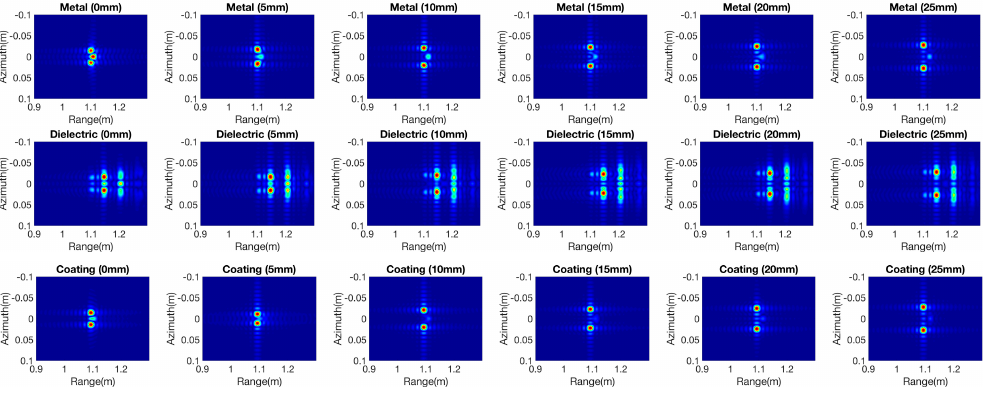
Figure 8. Images of metal sphere, dielectric sphere, and metal sphere coated with Teflon with a spacing of 0 mm, 5 mm, 10 mm, 15 mm, 20 mm and 25 mm. ( Top row : metal, middle row : dielectric and bottom row : metal coated with Teflon).